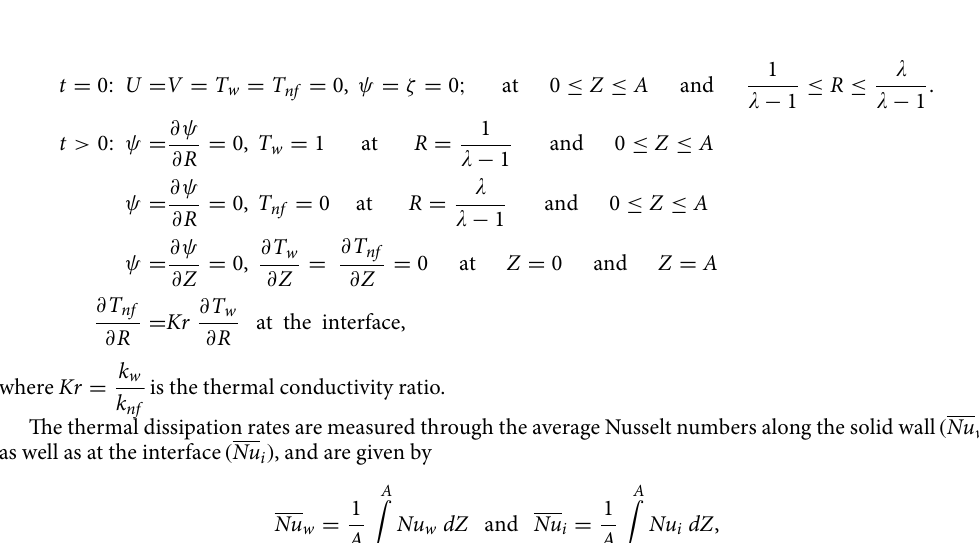
Table 2. Grid independence test for Ra = 10